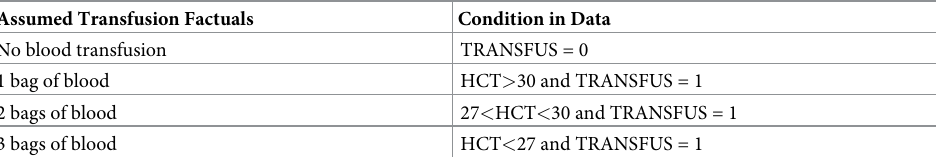
Table 1. Assumed baseline treatment.